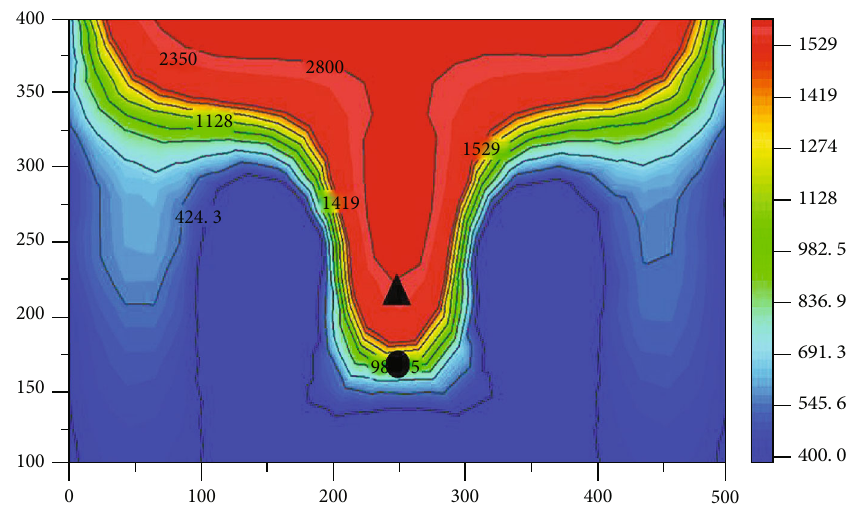
Figure 10: Pressure distribution at the end of the experiment (260 ° C, kPa).